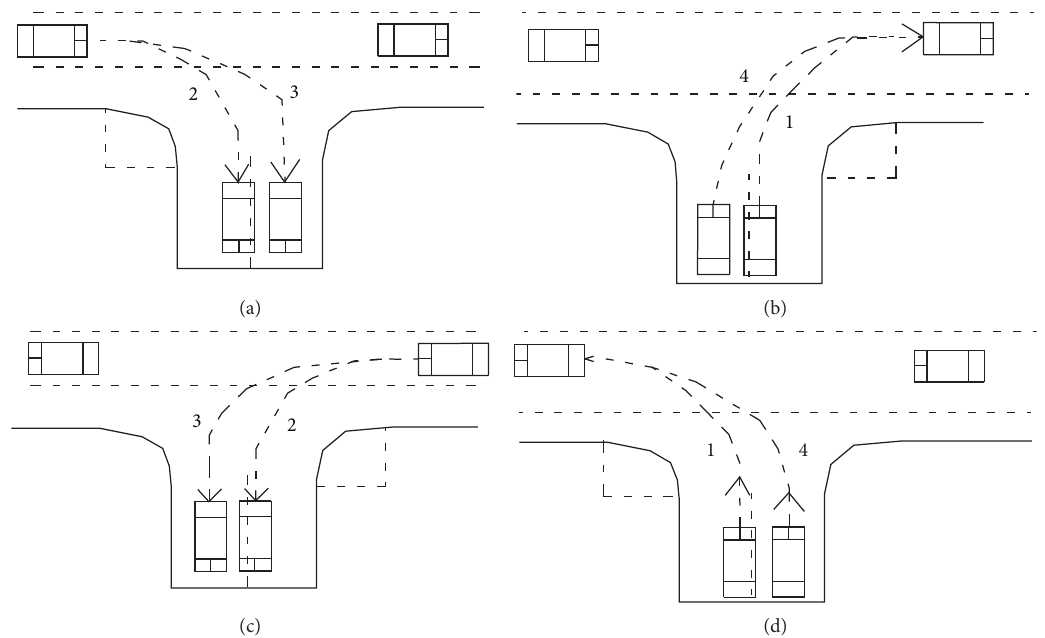
Figure 10: Interaction of turning movements. (a) Interaction of entering right turns. (b) Interaction of exiting right turns. (c) Interaction of entering left turns. (d) Interaction of exiting left